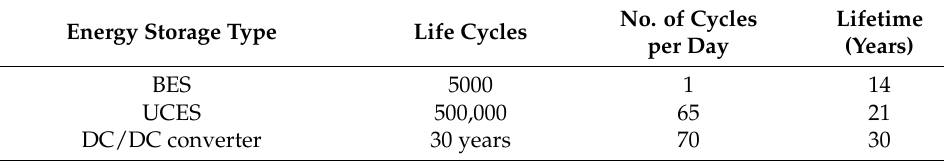
Table 4. Lifetime calculation based on the life cycle and the daily cycle of each